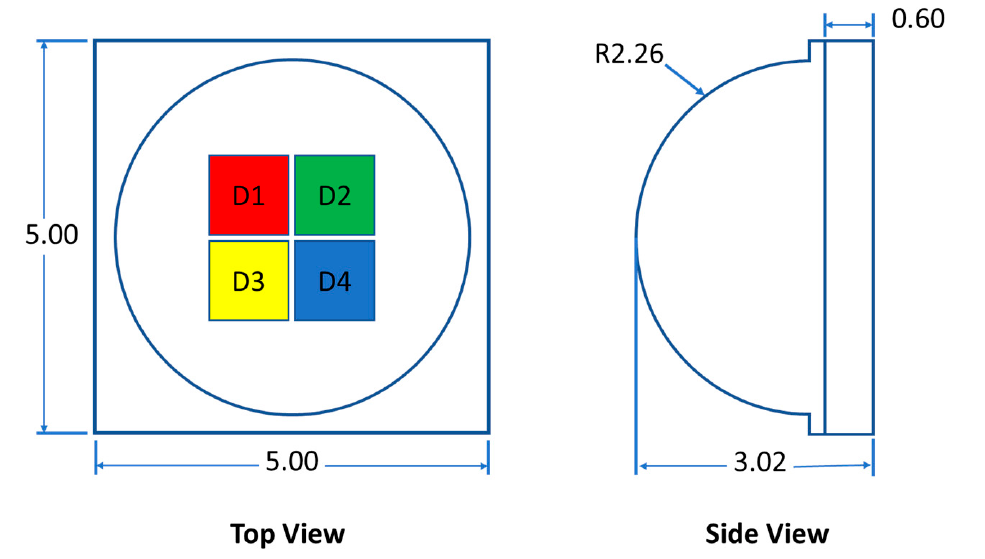
Figure 1. Structure of the investigated devices, adapted from [19]. All dimensions are in mm.